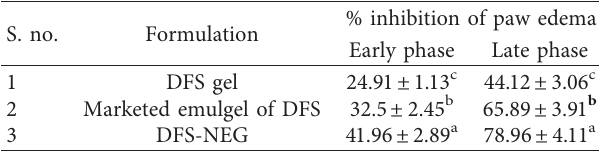
Table 3: Anti-inflammatory activity of test formulations as a measure of percentage (%) inhibition of paw edema (mean ±